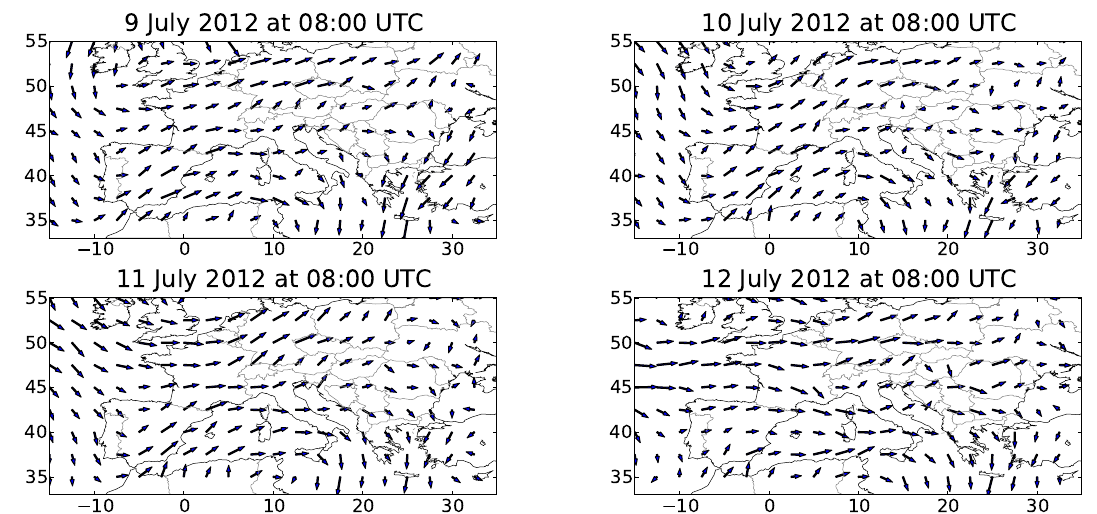
Figure 4. Wind fields (arrows) at about 2 km a . g . l . at 08:00 UTC on 9, 10, 11 and 12 July 2012. The data are interpolated from ECMWF fields.